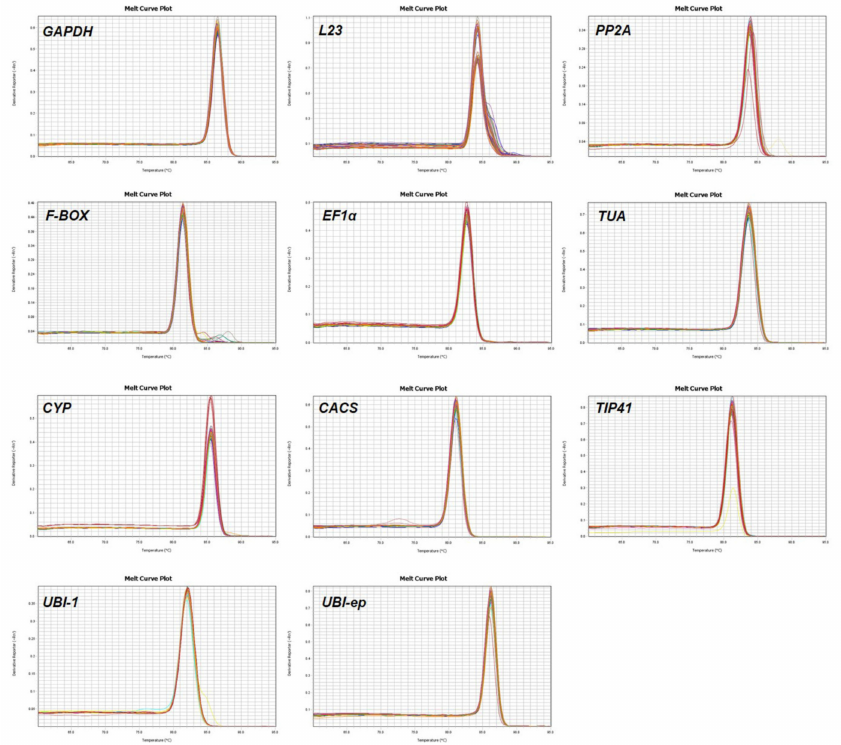
Figure 3. Dissociation curves of the eleven reference genes evaluated under experimental conditions, each showing a single